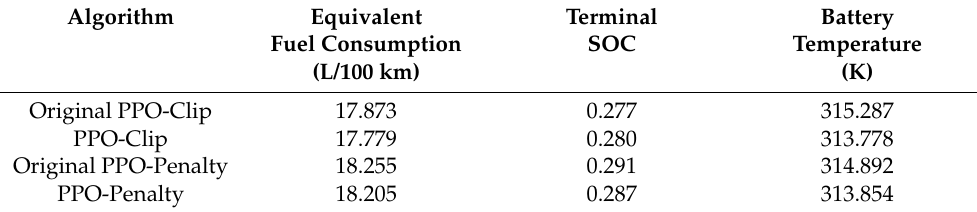
Table 5. Terminal battery temperature comparison in 4 × UDDS.